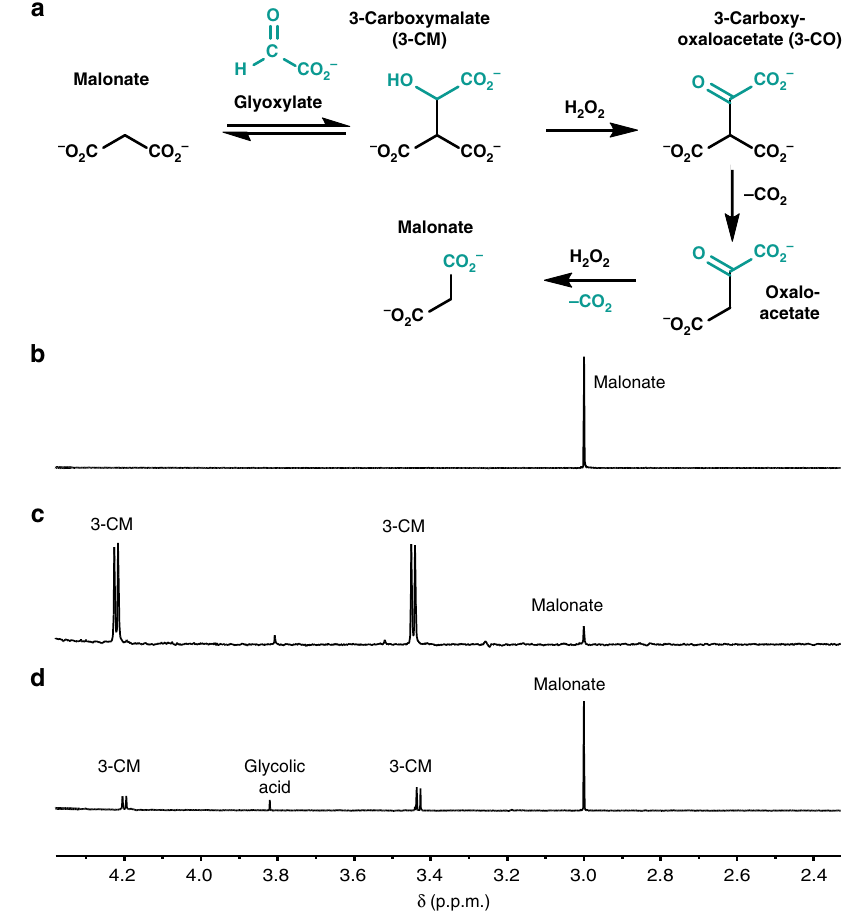
Fig. 3 Progression around the Malonate cycle. a The reaction pathway of the Malonate cycle, with glyoxylate-sourced atoms in turquoise. b 1 H NMR (in D 2 O) of a reaction aliquot from 90 mM disodium malonate in 1.0 M aq. bicarbonate buffer, pH 8.4. c A total of 3 eq. of glyoxylate was added and the reaction was heated for 24 h at 50 °C. d A total of 30 eq. of H 2 O 2 was added and the reaction continued at 50 °C for an additional 48 h. The production of malonate through the oxidative decarboxylation of oxaloacetate, apart from the retro-aldol of 3-CM, was demonstrated by 13 C labeling, as will be shown below